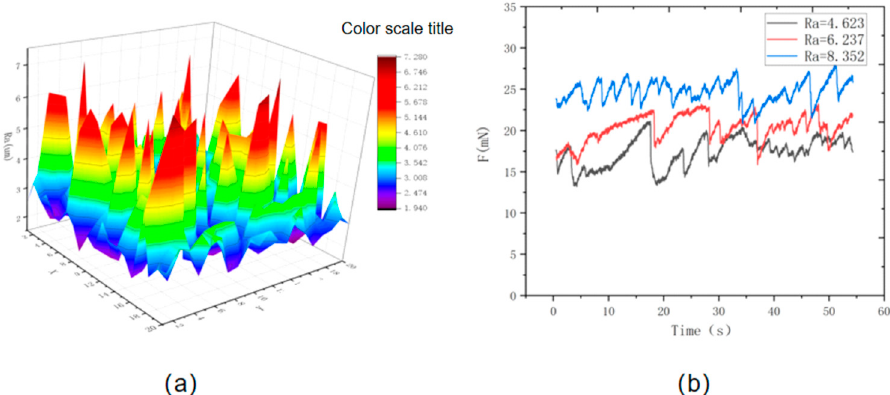
Figure 4. ( a ) The change in the surface roughness of the concrete after stabilization processing; ( b ) the change curve of the friction of the concrete material with different roughness.